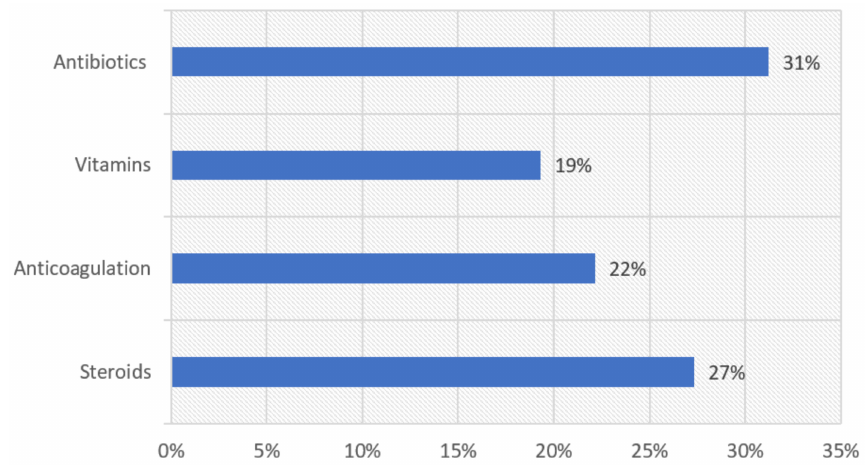
Figure 6. Treatment of hospitalised COVID-19 patients in Limpopo